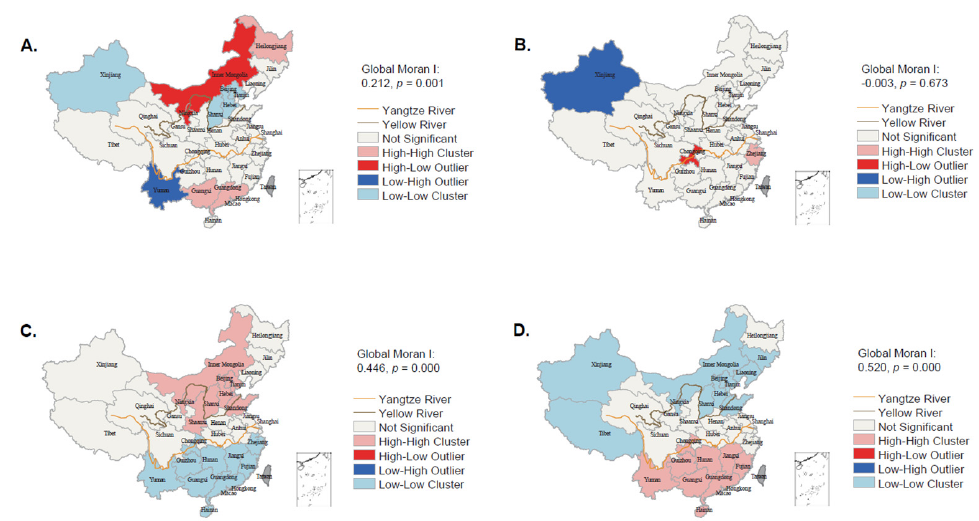
Figure 2. The clusters of provinces with high or low proportions for each dietary pattern; identified by spatial analyses. ( A ). Common rice-based dietary pattern; ( B ). Prudent dietary pattern; ( C ). Northern wheat-based pattern; ( D ). Southern rice-based pattern.